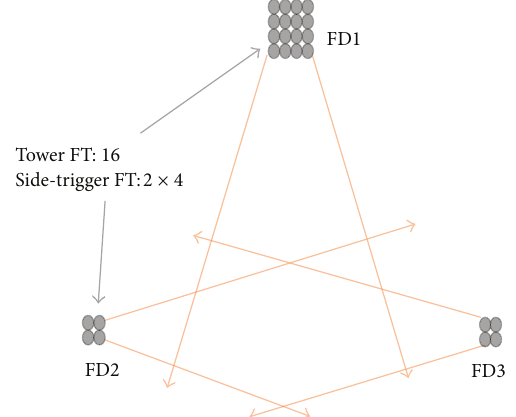
Figure 3: The configuration of the fluorescence telescope array. The solid circles are the fluorescence telescopes. The lines illustrate the detector FOV along the